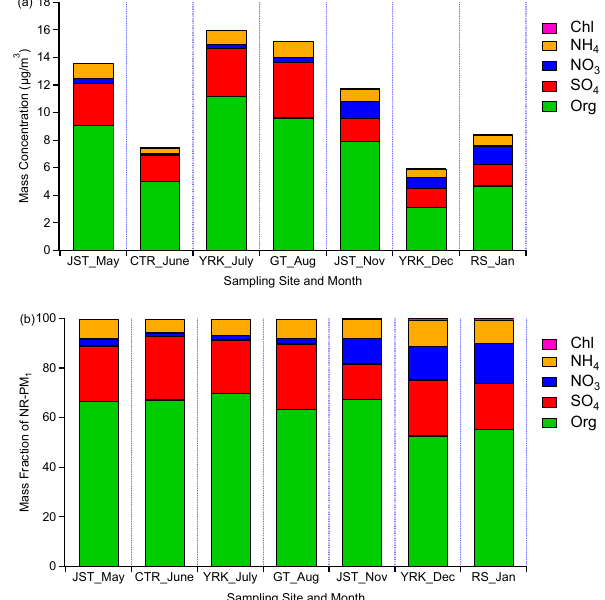
Figure 2. Mass concentrations (a) and mass fractions (b) of non- refractory PM 1 (NR-PM 1 ) species measured by HR-ToF-AMS.